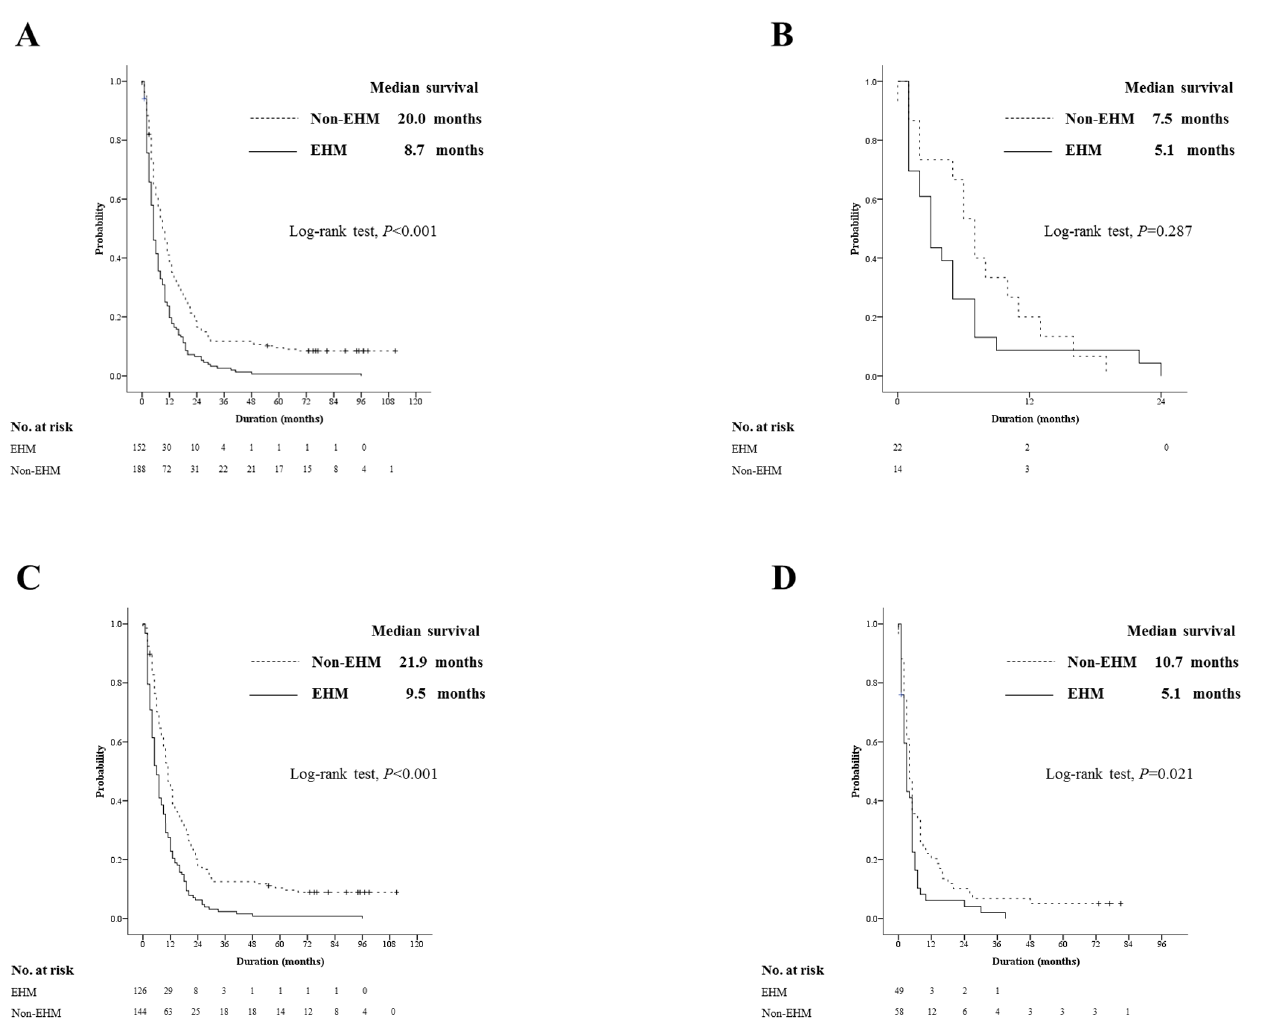
Figure 3. Survival analysis based on intrahepatic stage and liver function. Subgroup analysis based on the intrahepatic stage and liver function was undertaken. The solid line represents patients with EHM and the dotted line for patients without EHM: The graphs demonstrates the comparisons of OS between the EHM group and the non-EHM group (A) in patients with T3 intrahepatic tumor (median, 8.7 months vs. 20.0 months; P , 0.001), (B) in those with T4 tumor (median, 5.1 months vs. 7.5 months; P 5 0.287), (C) in those with Child-Pugh class A liver function (median, 9.5 months vs. 21.9 months; P , 0.001), and (D) in those with Child-Pugh class B (5.1 months vs. 10.7 months; P 5 0.021),